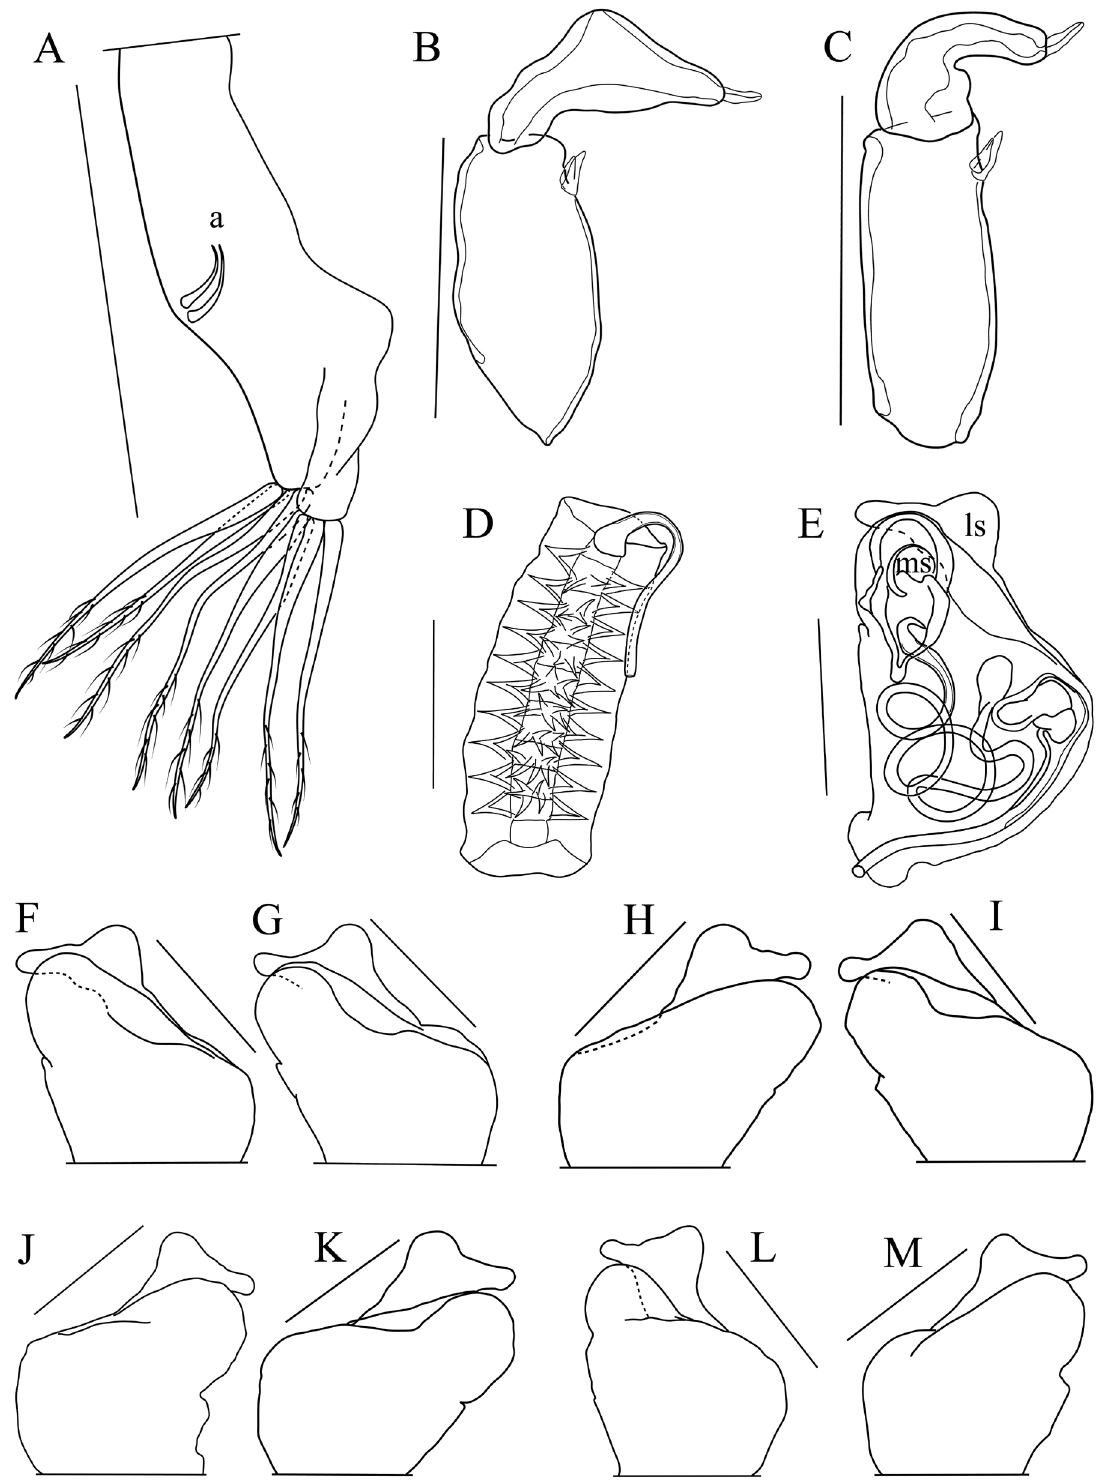
Fig. 15. Brasilodopsis amazonica gen. et sp. nov. from Amazon River floodplain, ♂. A . T1 (MZUSP 41852). B . Rpp (MZUSP 41852). C . Lpp (MZUSP 41852). D . Zenker’s organ (MZUSP 41852). E–G . Hemipenis (MZUSP 41852). H–I . Hemipenis (MZUSP 41856). J–K . Hemipenis (MZUSP 41854). L–M . Hemipenis (MZUSP 41855). Abbreviations: see text and Material and methods. Scale bars: 50